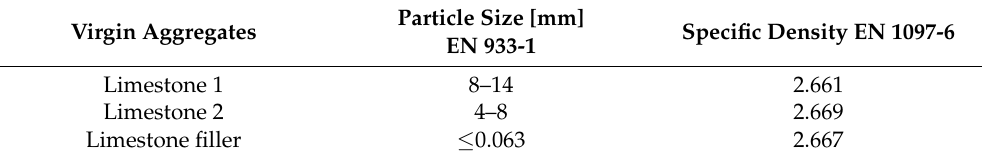
Table A3. Aggregates typical values.